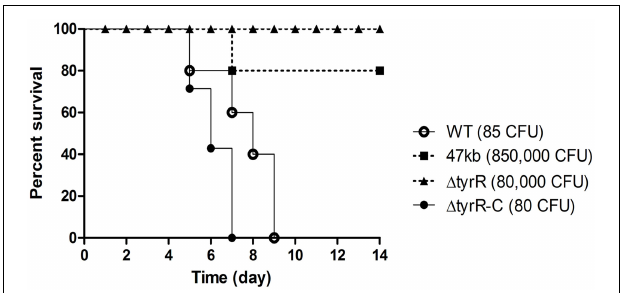
FIGURE 1 | Effect of the tyrR gene on Y. pestis pathogenesis in mice. Groups of five or seven BALB/c mice were inoculated by subcutaneous injection with appropriated dose of Y. pestis strain 201 (open circles), 47-kb mutant (filled diamonds), tyrR (filled triangles) or tyrR complementary strain (filled circles). Mice mortality was monitored for 14d.